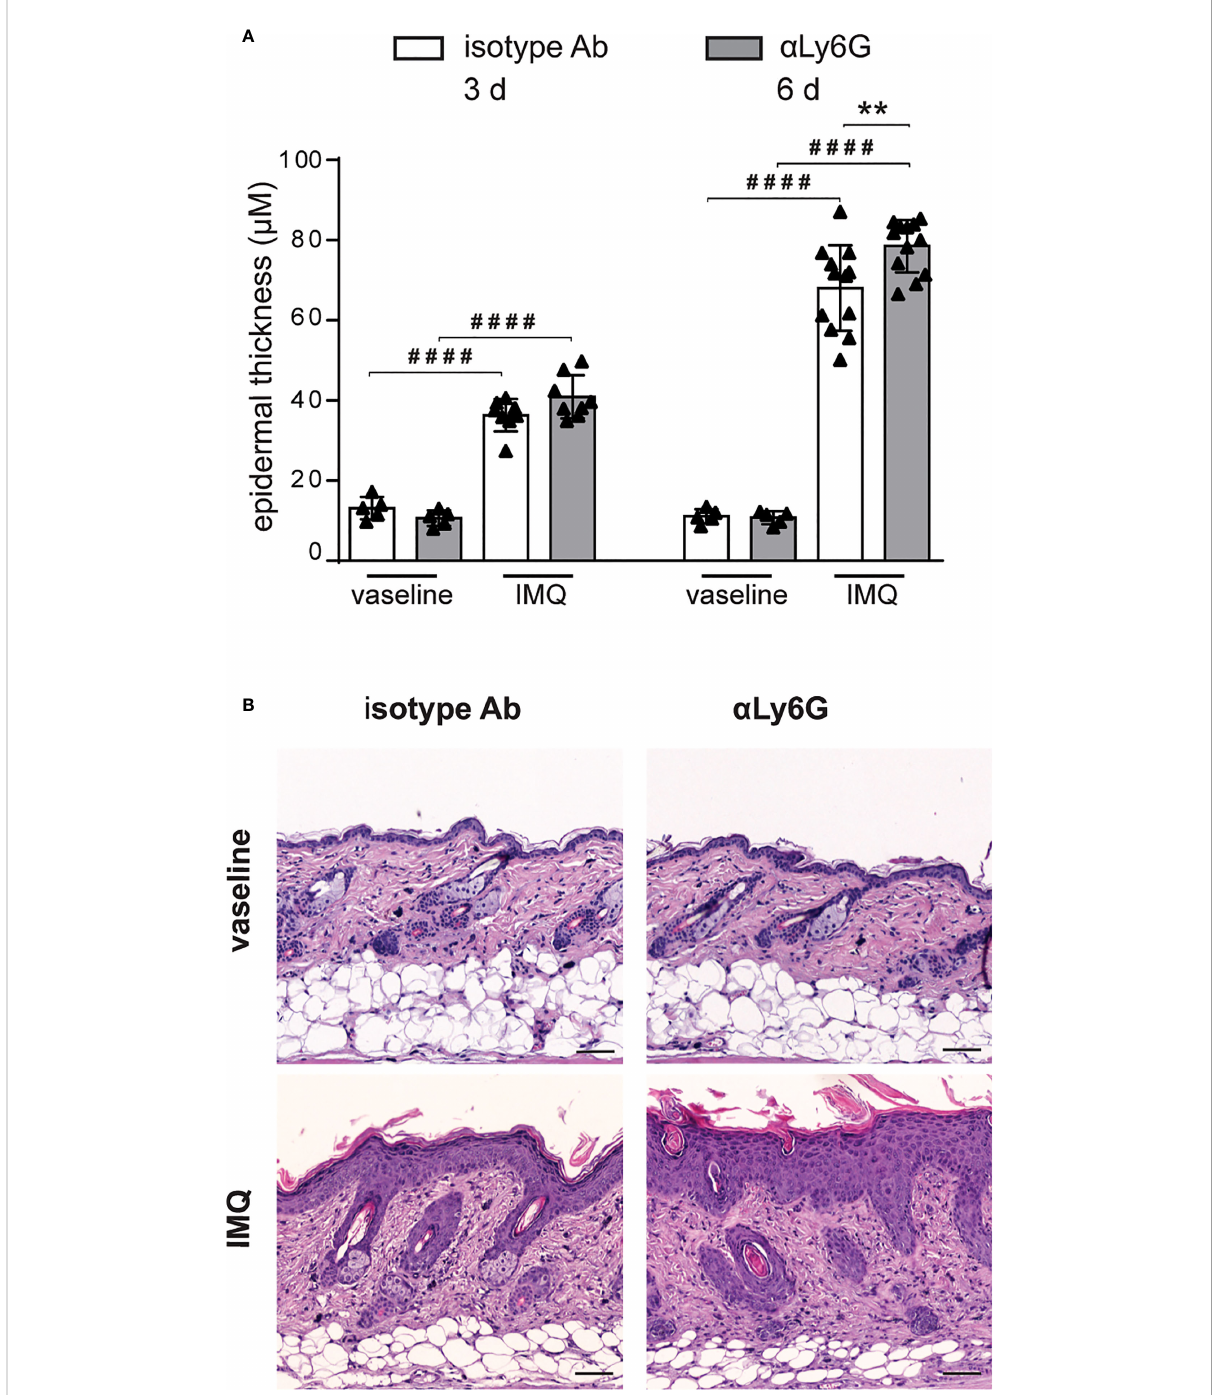
FIGURE 1 Increased epidermal thickening in neutrophil-depleted mice in response to IMQ treatment. Dorsal skin of mice was topically treated with vaseline or IMQ-containing cream (Aldara ® ) for 3 or 6 consecutive days. Mice were injected with the depleting antibody a Ly6G or isotype control antibody. (A) The height of epidermal hyperplasia was measured in interfollicular epidermis on H&E-stained slides by light microscopic evaluation. Data are pooled from 3 separate time course experiments and are expressed as means ± SD (n = 5-12). Statistical differences of IMQ-treated vs . vaseline-treated mice (#) and IMQ-treated control vs . neutrophil-depleted mice (*) are reported. ** P ≤ 0.01; #### P ≤ 0.0001 by 1-way ANOVA with Bonferroni ’ s post-test. (B) Representative H&E-staining of dorsal skin from mice injected with isotype Ab or a Ly6G treated with vaseline or IMQ for 6 days. Original magni fi cation, X100; original scale bars 40 m